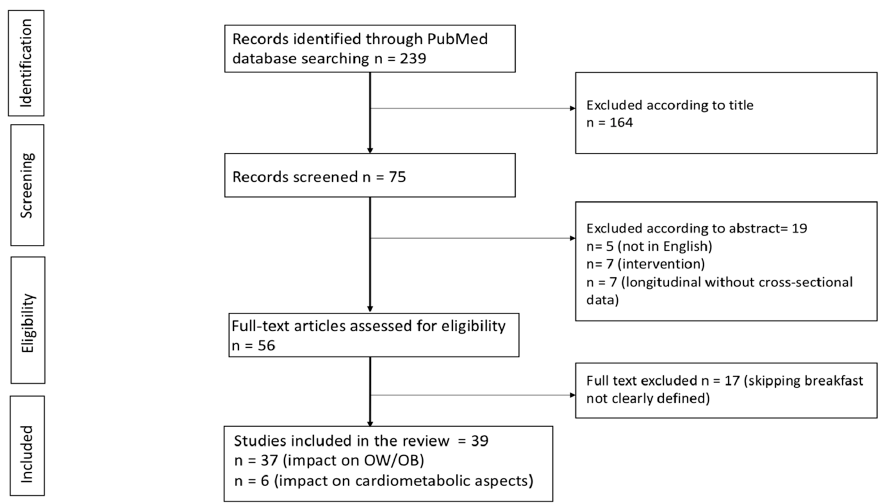
Figure 1. Flow diagram for study retrieval and selection.